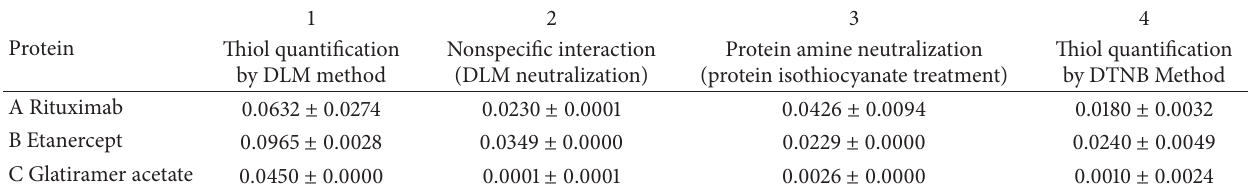
Table 5: DyLight Maleimide method and nonspecific interactions tests under native conditions.